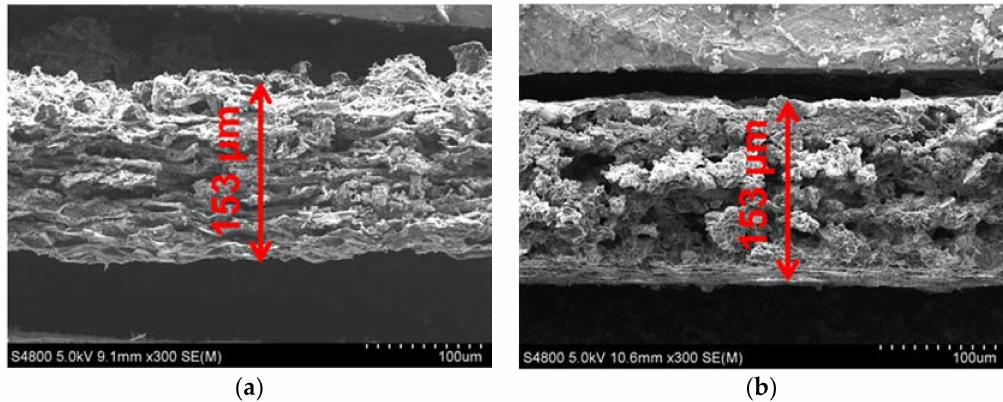
Figure 5. SEM images of the Si/G/CP composite electrode with 16 wt % and 1.0 µ m Si. ( a ) Initial and ( b ) after 100